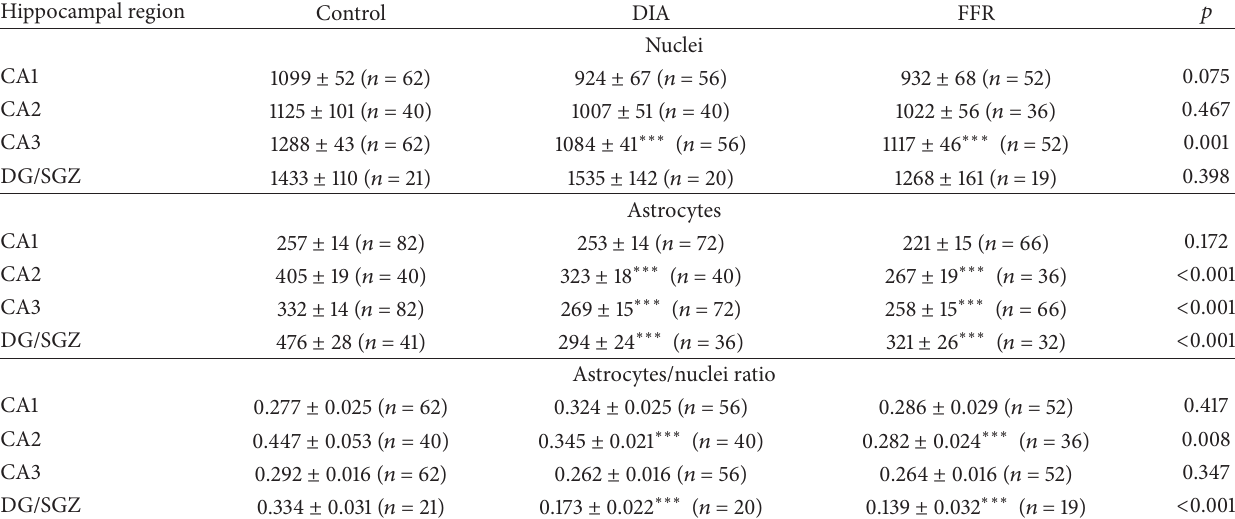
Table 1: Regional changes in astrocyte density in DIA and